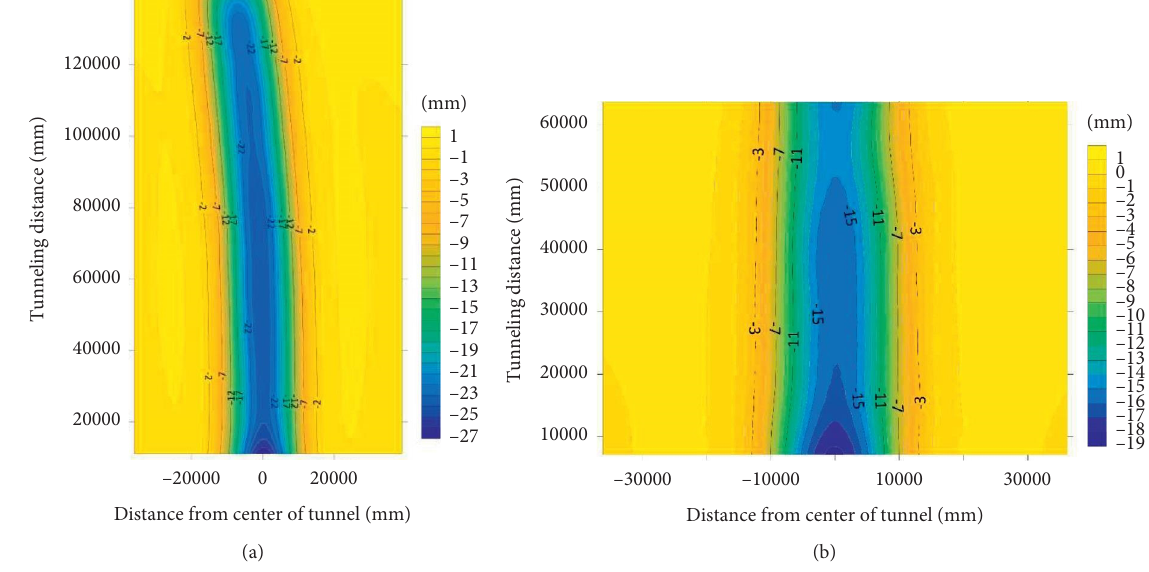
Figure 8: Final ground surface settlement contourline of shield and pipe jacking by numerical simulation: (a) Final settlement contourline of the shield. (b) Final settlement contourline of pipe Table 3 and Figure 14. The critical ground loss rate δ of quasi-rectangular tunnels should be between the two, namely, δ < δ < δ . When the ground loss rate of quasi- 2 1 rectangular tunnel is controlled below the critical value, the maximum ground settlement value can meet the control index of 30 mm.